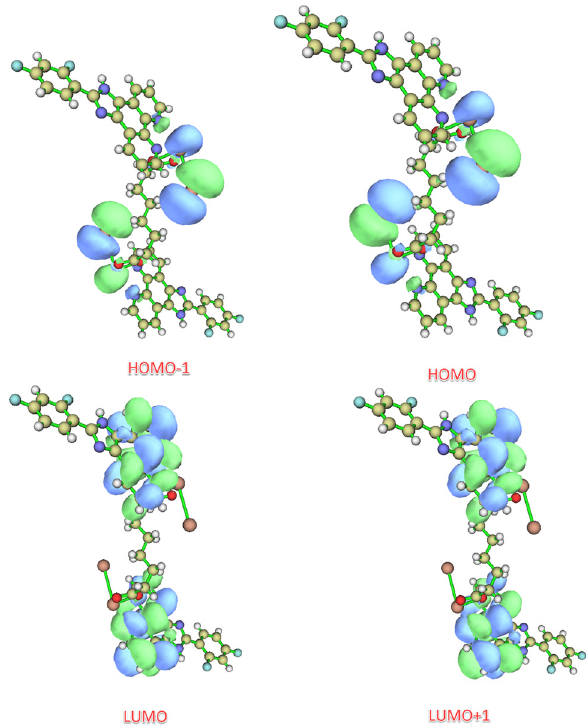
Figure 7: View of the frontier molecular orbitals of 1